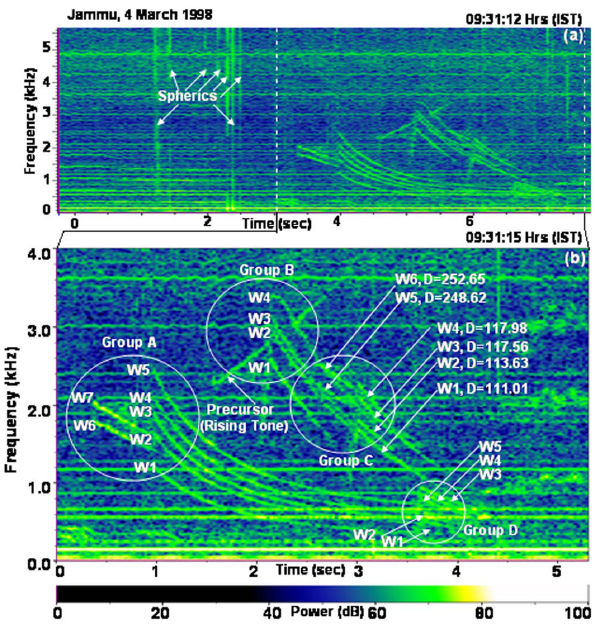
Fig. 1. (a) The frequency-time spectrogram of multiflash ELF whistlers observed in local daytime on 4 March 1998 at 09:31:12IST at low latitude station Jammu. The corresponding causative spherics are marked by arrows. (b) The frequency-time spectrograms of enlarged four sets of above group of ELF whistlers starting at 09:31:15IST along with a precursor emission which is marked by